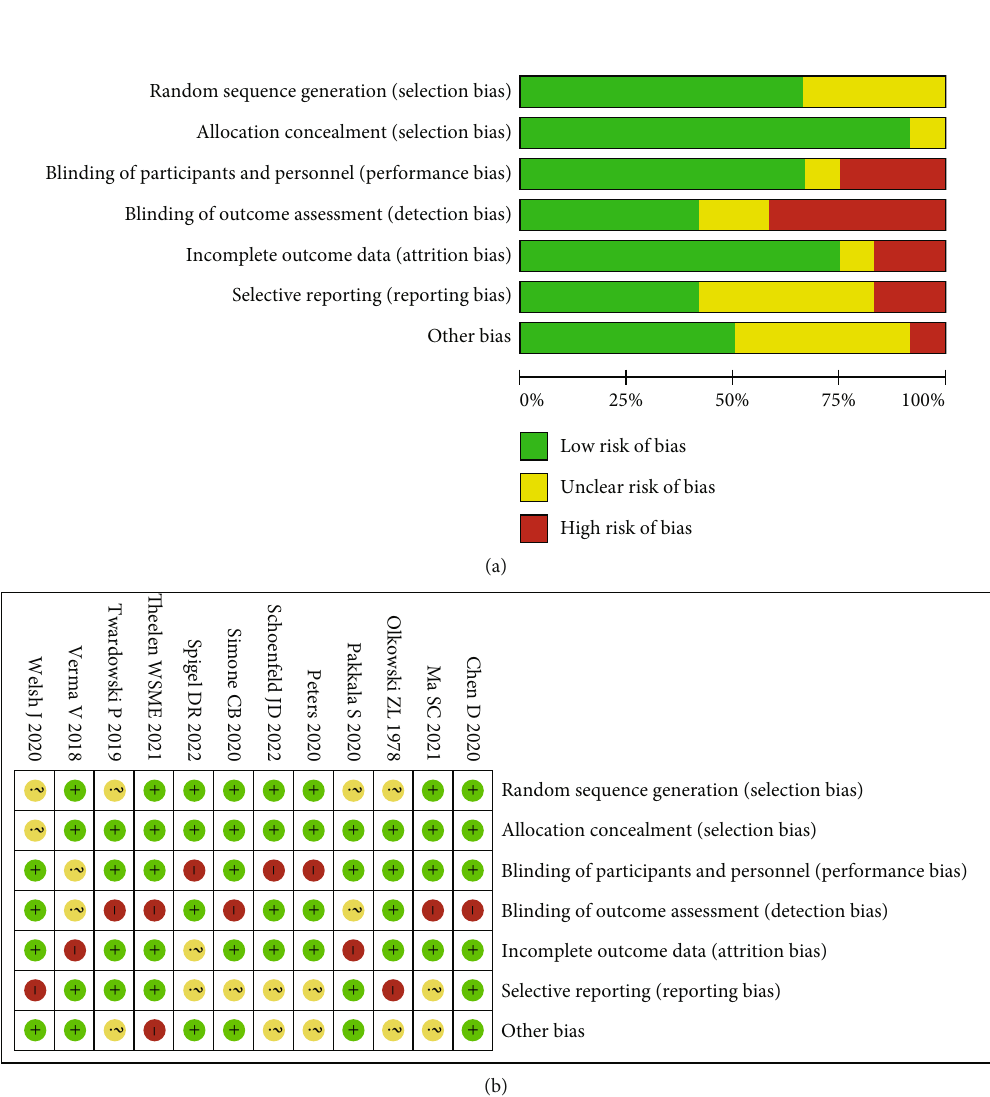
Figure 6: The evaluation chart of literature quality. (a) Risk level of bias graph. (b) Risk level of bias